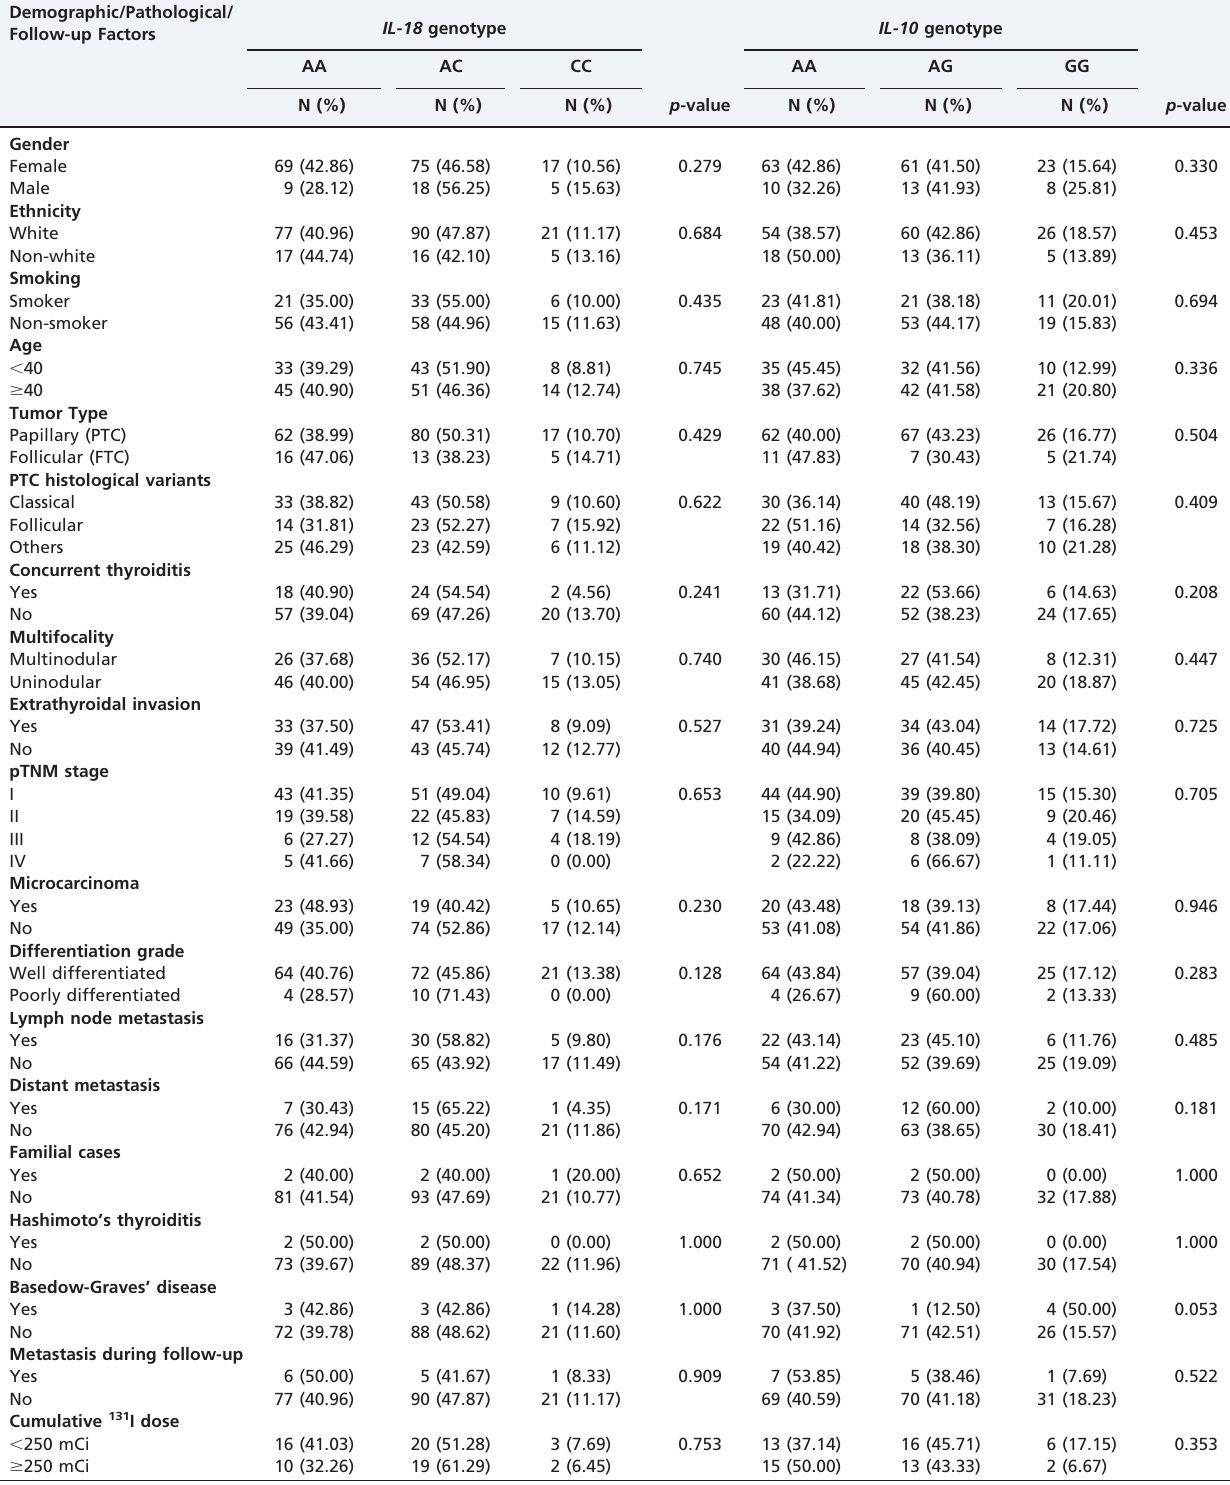
Table 1 - Demographics, pathological features and follow-up characteristics of the differentiated thyroid cancer patients according to their genotypic distribution of interleukin-18 + 105A/C ( IL-18 + 105A/C) and interleukin-10 -1082A/ G ( IL-10 -1082A/G) polymorphic profiles. PTC= papillary thyroid carcinoma; N= absolute number of patients; pTNM= International Union Against Cancer (AJCC/UICC) staging